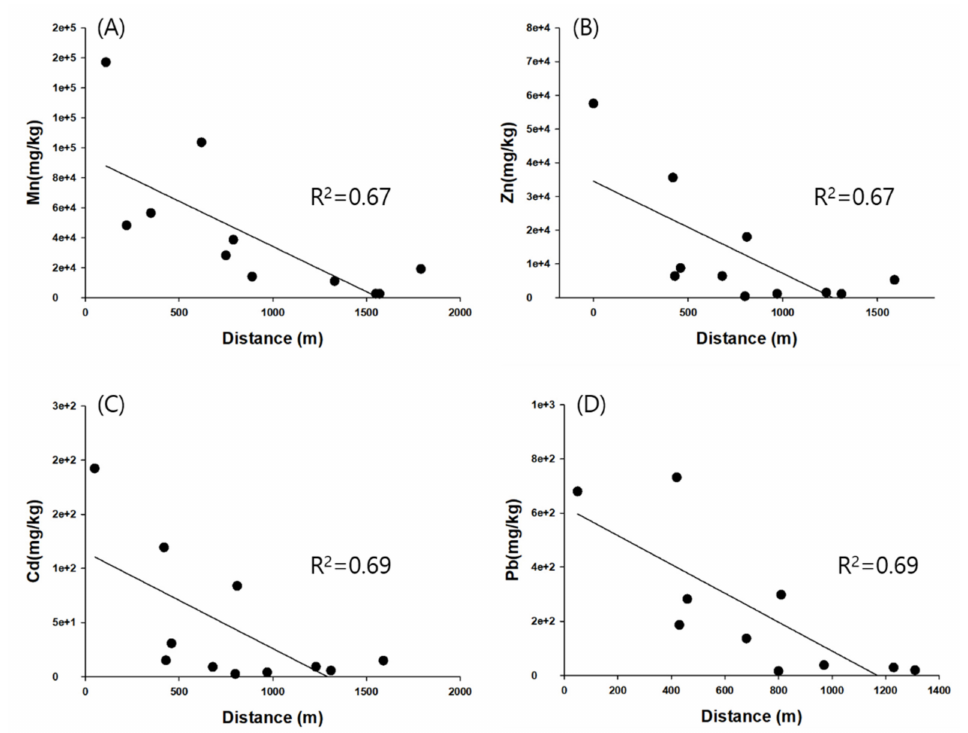
Figure 2. Spatial distribution of ( A ) Mn, ( B ) Zn, ( C ) Cd, and ( D ) Pb in topsoil and urban dust in Donghae